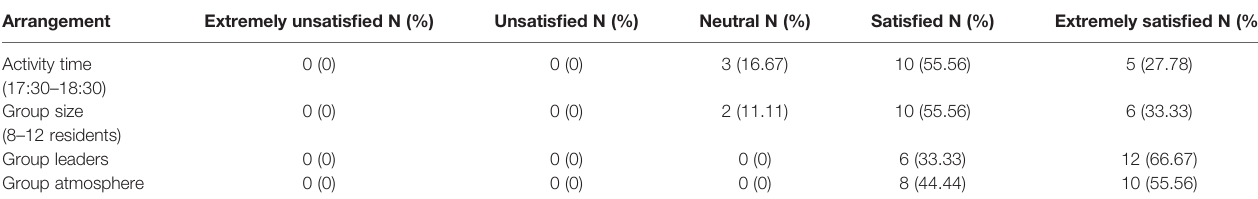
TABLE 6 | Participants' satisfaction with program arrangement in the intervention group (n = 18). Arrangement